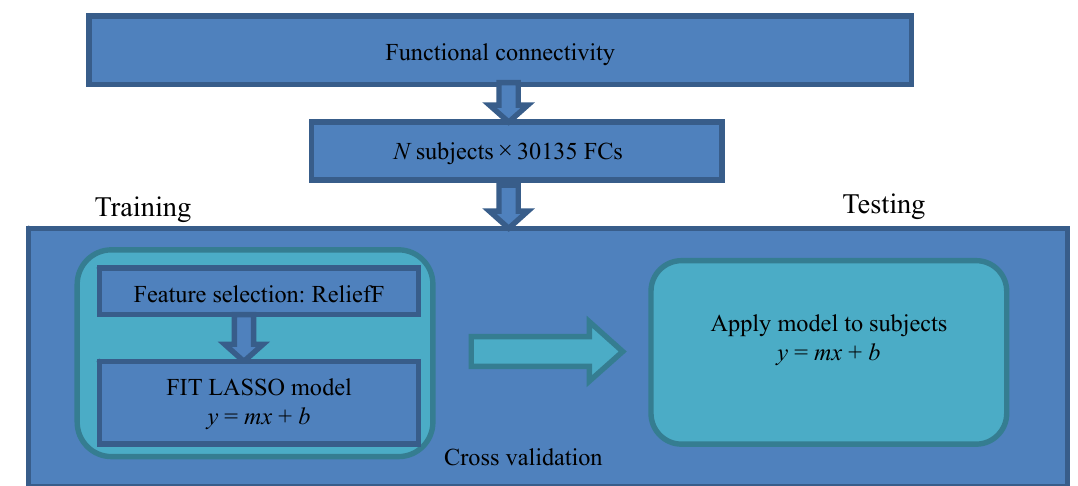
Fig 2: Proposed framework showing feature selection and regression analysis using Brainnetome Atlas based functional connectivity [22] .